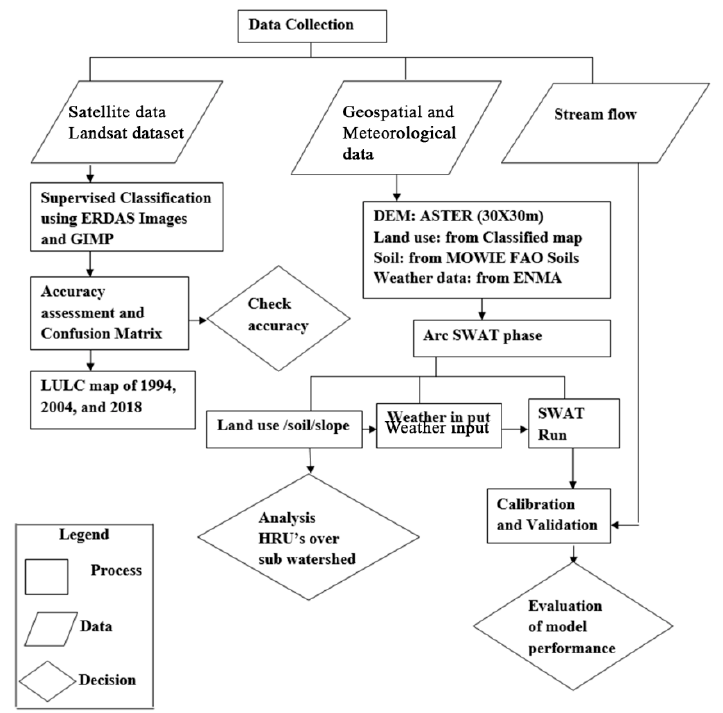
Figure 2. Conceptual framework of the study.